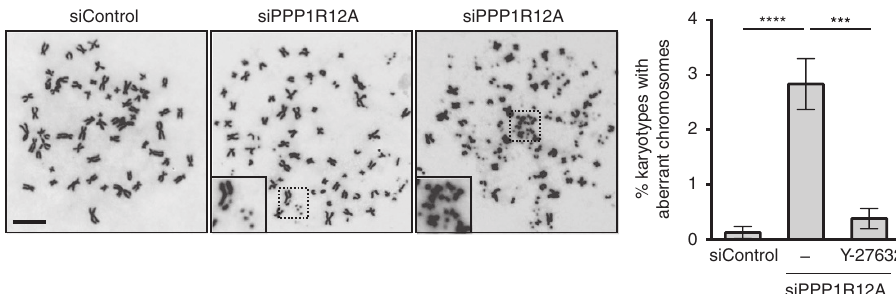
Figure 7 | Loss of PPP1R12A causes contractility-dependent gross chromosomal aberrations. Cells were treated with 5 m M Y-27632 for 24h before fixation. Mitotic cells were collected by shake-off after the treatment with 330nM nocodazole and 2mM caffeine for 5h. Mitotic chromosomes were analysed by chromosome spreading and Giemsa staining. Example karyotypes (left panel) and quantification of karyotypes with abnormal chromosomes (right panel) are shown. Error bars, s.d. of three independent experiments ( n 4 300 spreads each). Graph shows *** P ¼ 0.0001, **** P o 0.0001 (one-way ANOVA Tukey’s multiple comparison test). Scale bars, 10 m